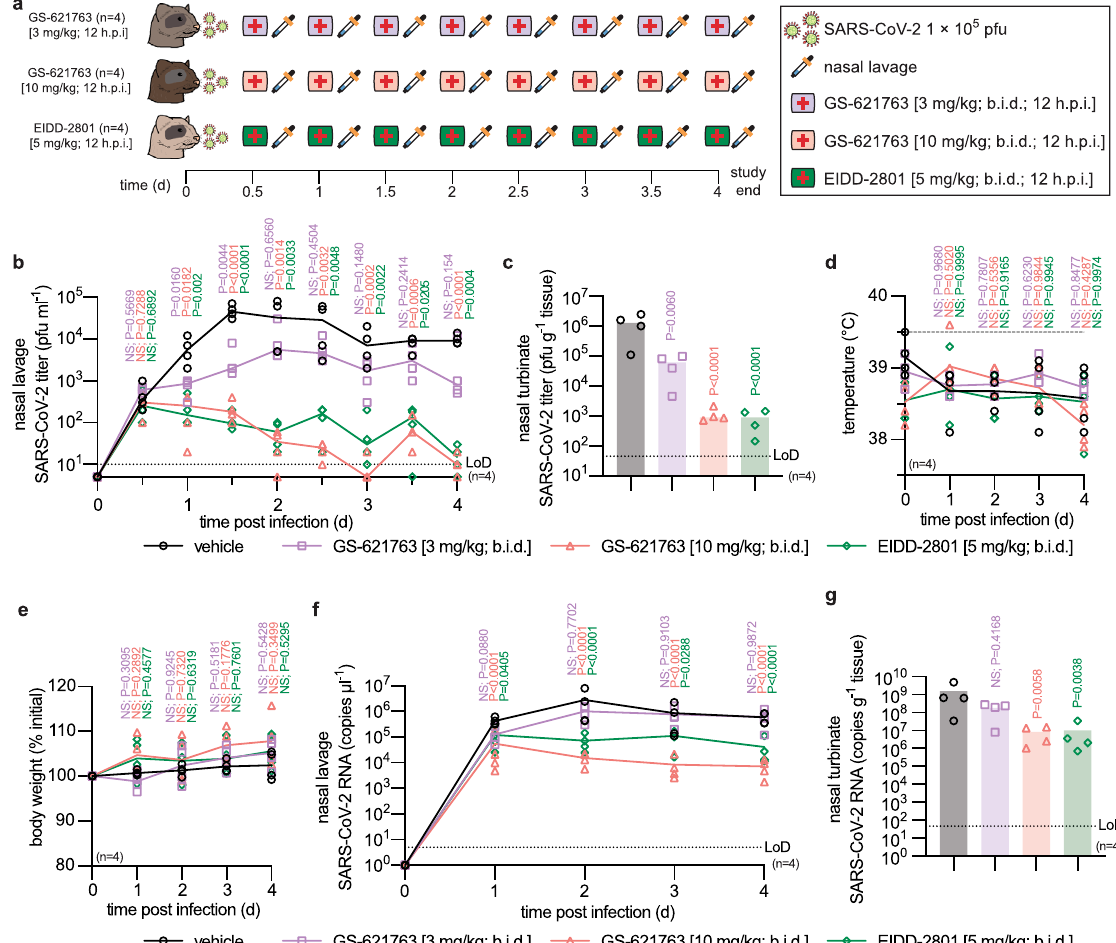
Fig. 3 Therapeutic ef fi cacy of GS-621763. a Schematic of the therapeutic ef fi cacy study design. Ferrets were infected intranasally with 1 × 10 5 pfu WA1/ 2020. Symbols as described for Fig. 2a. Starting 12 h after infection, groups of ferrets ( n = 4) were gavaged b.i.d. with vehicle (black circles in b – g), GS- 621763 (3 mg/kg (purple fi rst aid symbol; purple circles in b – g ) or 10 mg/kg (pink fi rst aid symbol; red circles in b – g )), or treated with EIDD-2801 (5 mg/ kg (green fi rst aid symbol; green diamonds in b-g)). Nasal lavages were harvested twice daily. Animals were terminated 4 days after infection. b Virus titers from nasal lavages. c , Infectious titers of SARS-CoV-2 in nasal turbinates harvested four days after infection. d Temperature measurements collected once daily. e Body weight measured once daily. f SARS-CoV-2 RNA copies present in nasal lavages. g SARS-CoV-2 RNA copies detected in nasal turbinates. The number of independent biological repeats (individual animals) is shown in each subpanel. Symbols represent independent biological repeats, lines ( b, d, e, f ) and bar graphs ( c, g ) connect or show samples mean, respectively, and P values are stated. 1-way ( c, g ) or 2-way ( b, d, e, f ) ANOVA with Dunnett ’ s post hoc multiple comparison tests. LoD limit